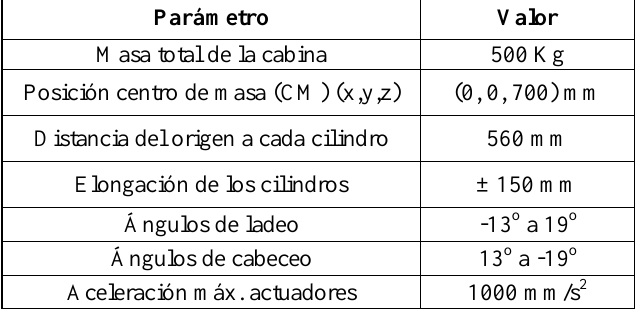
Tabla 1: Datos Mecánicos del